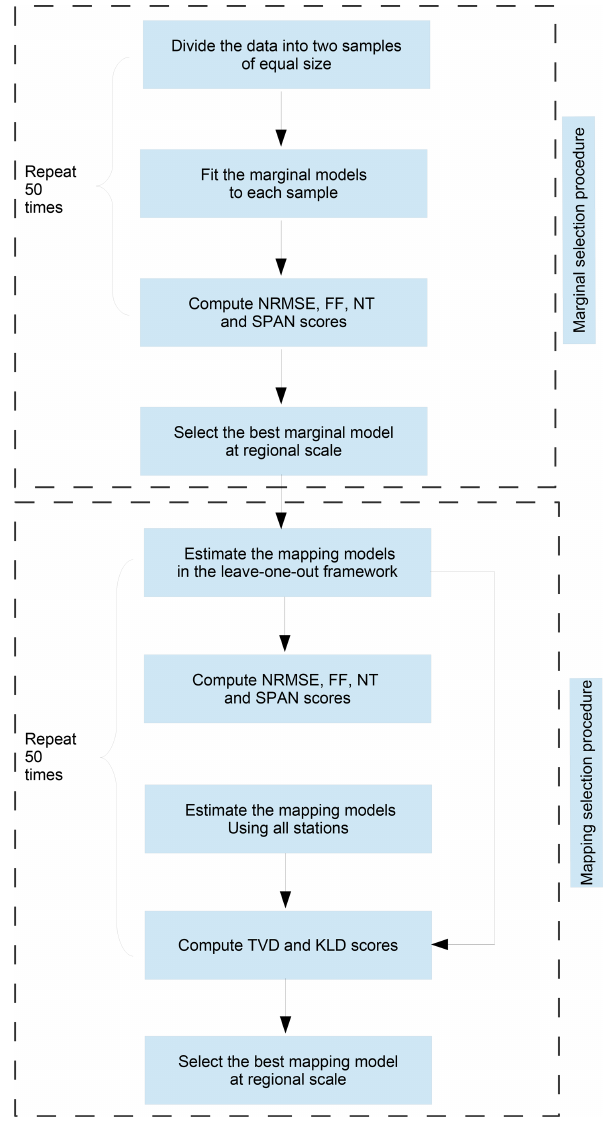
Figure 5. Schematic summary of the full cross-validation procedure for selecting both the marginal and mapping